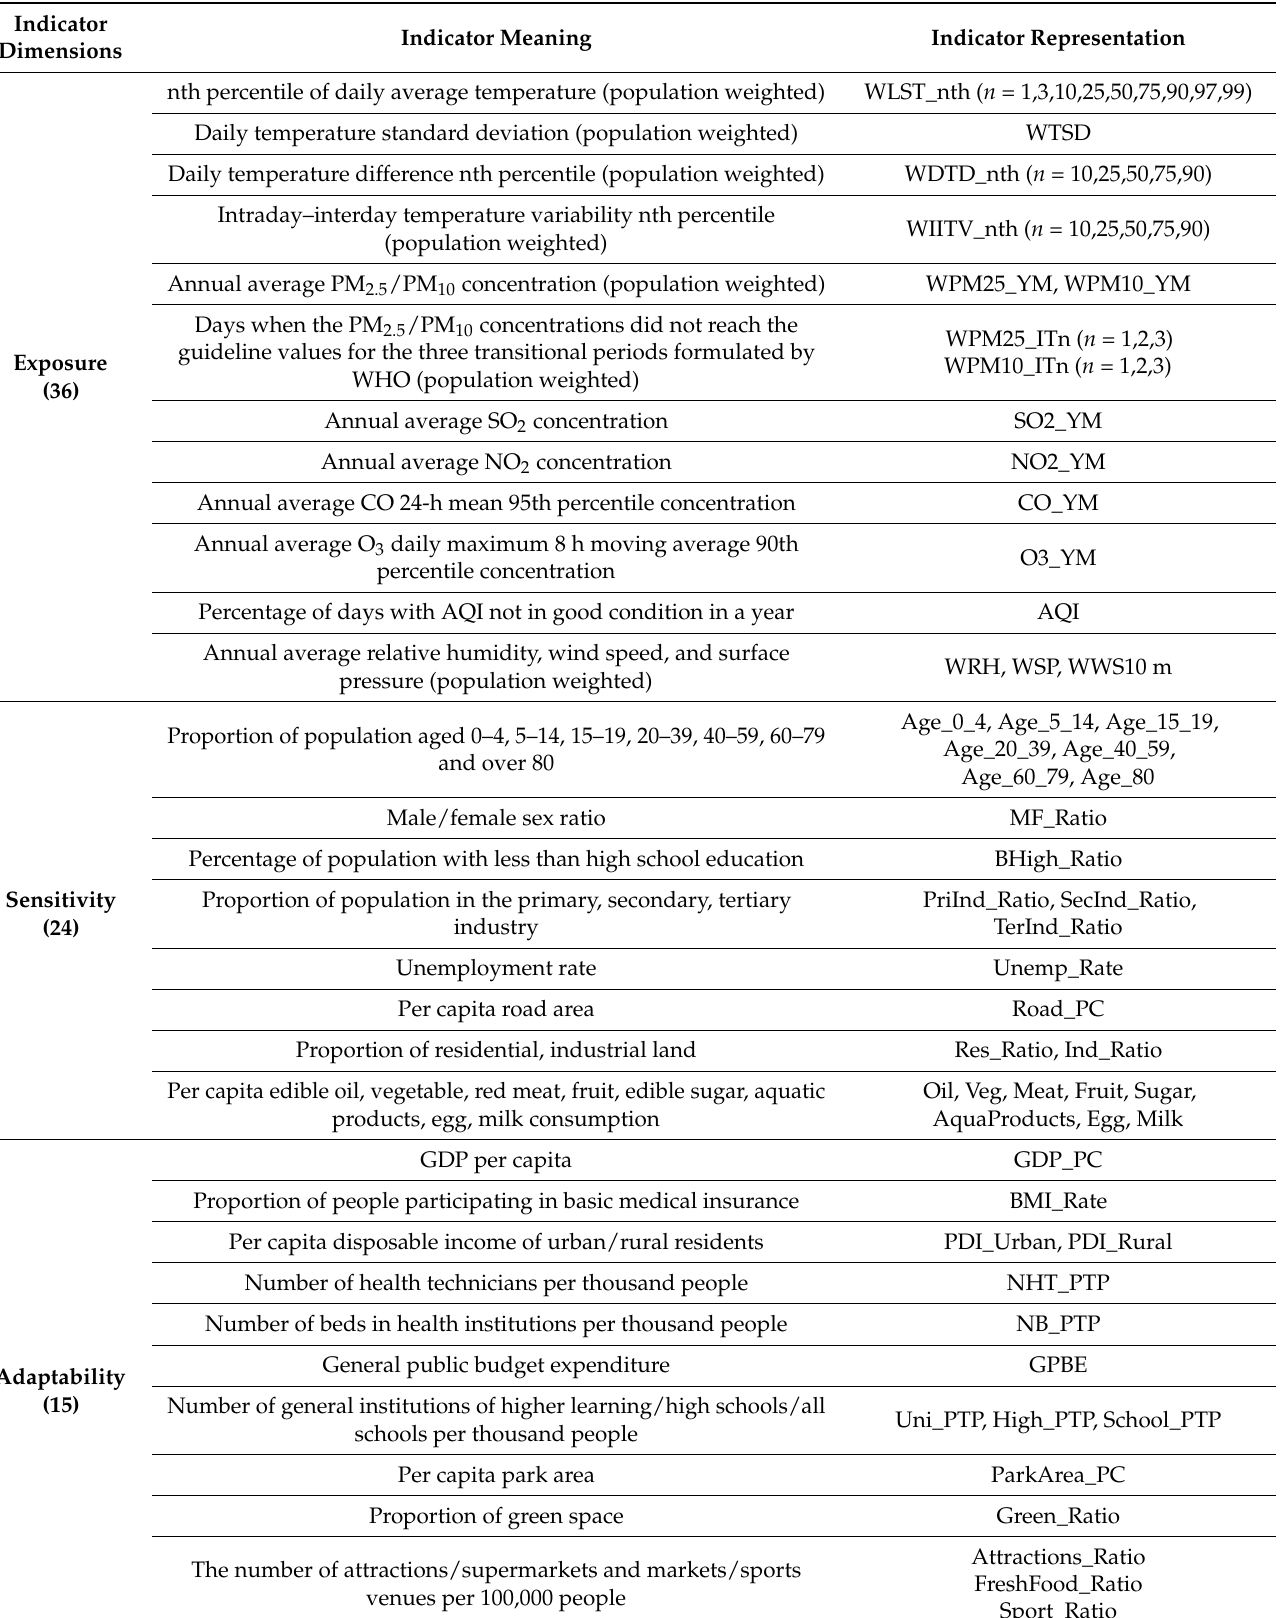
Table 1. Population health vulnerability evaluation indexes